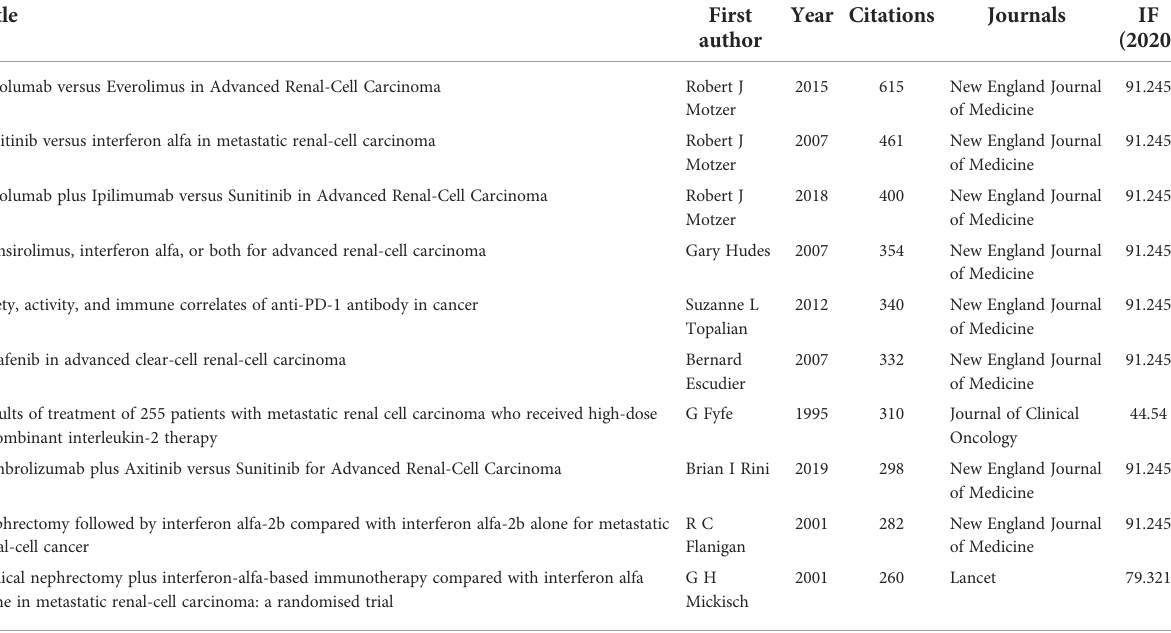
TABLE 6 Top 10 co-cited references involved in the research of RCC